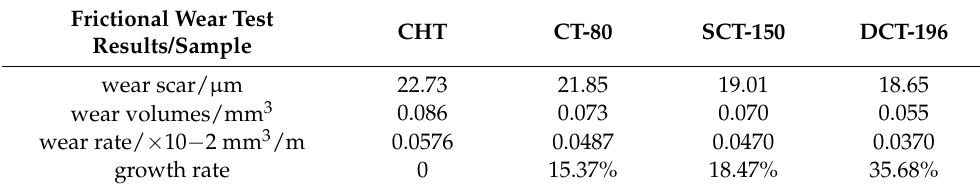
Table 5. The friction and wear test results of the